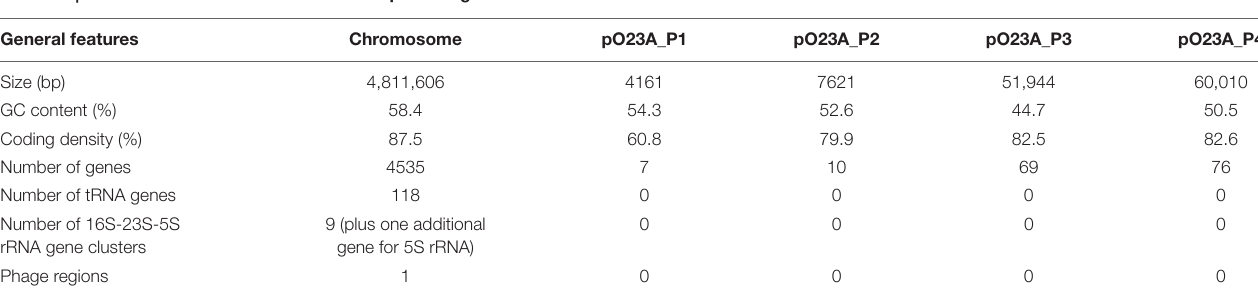
FIGURE 1 | Physical maps of the chromosome and plasmids of Aeromonas sp. O23A. Open reading frames are represented as orange and green blocks. The innermost circle represents GC skew, whereas the lager circles – GC content, CRISPR regions and RNA genes, respectively. The identified heavy metal resistance and metabolism modules are indicated as colored rectangles, forming the outermost part of the physical map of the O23A chromosome. TABLE 1 | General features of the Aeromonas sp. O23A